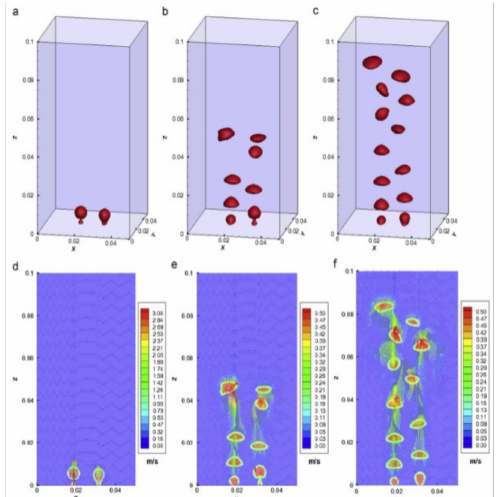
Figure 10. Snapshots ( a – c ) and velocity vectors ( d – f ) during the rising of two parallel bubbles when the distance between the two orifice centers was 12.75 mm, vg = 3 m/s, and vl = 0.01 m/s. ( a ) t = 0.050 s, ( b ) t = 0.225 s, ( c ) t = 0.375 s, ( d ) t = 0.050 s, ( e ) t = 0.225 s, and ( f ) t = 0.375